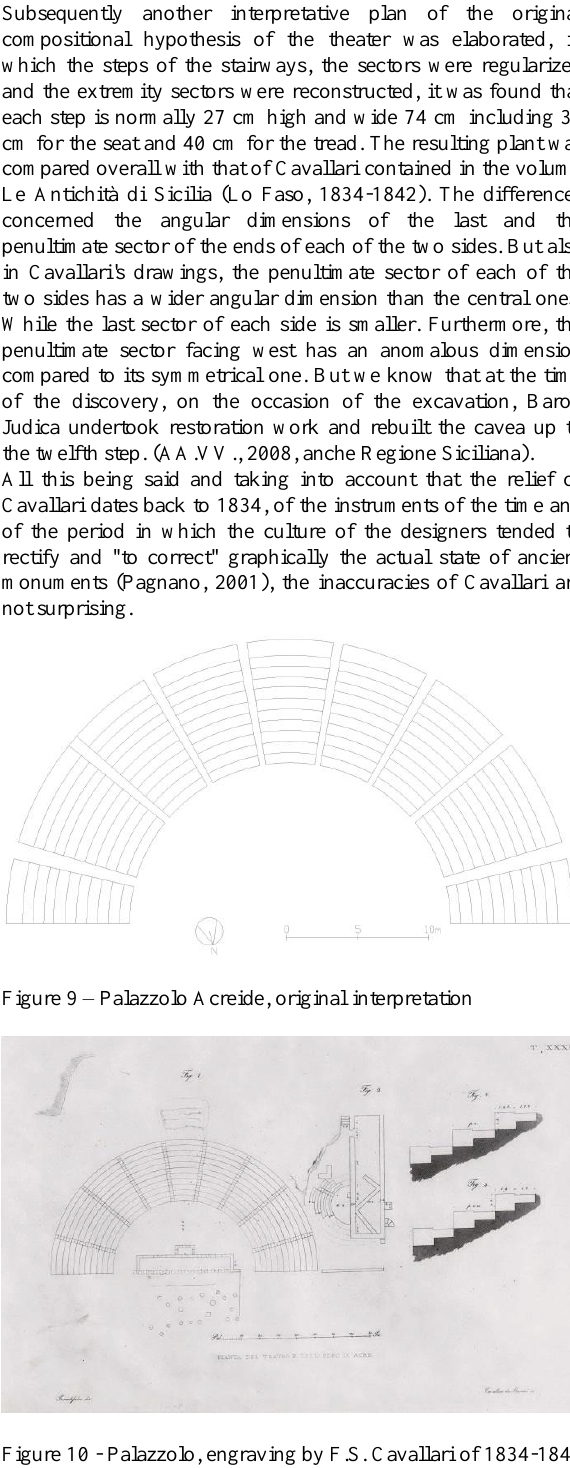
Figure 10 - Palazzolo, engraving by F.S. Cavallari of 1834-1842